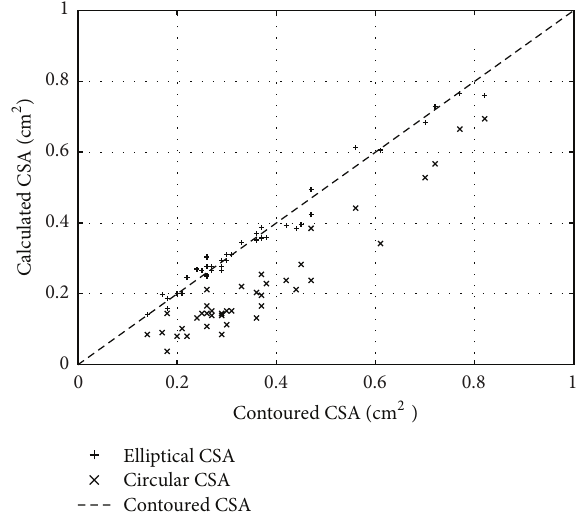
Figure 3: The elliptical (cross points) and circular CSA ( × points) of the jugular vein of one subject are plotted as a function of the measured CSA (interrupted line), clearly showing the underestima- tion of the circular CSA. The automated measure of the circular CSA is based on the erroneous assumption of the circular shape of the jugular